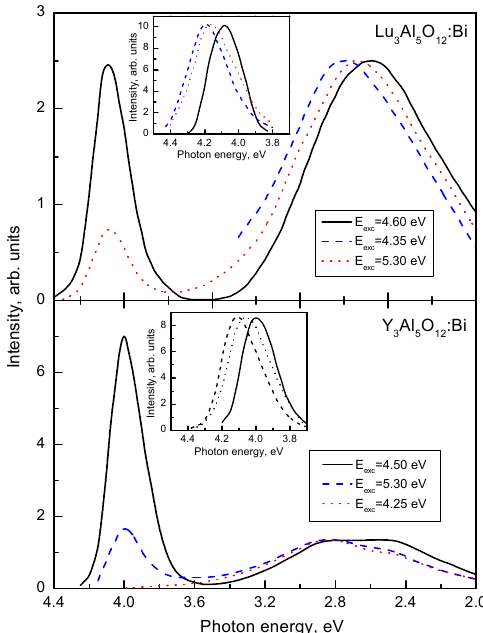
Figure 1. Emission spectra (normalized) of Lu 3 Al 5 O 12 :Bi and Y 3 Al 5 O 12 :Bi measured at 80 K under different excitations shown in the legends. In the insets, the ultraviolet emission spectra of Bi 3+ centers (normalized) measured at 80 K (solid line), 150 K (dashed line), and 300 K (dotted line). Based on the data reported in [17,18], presented with the publisher’s permission.